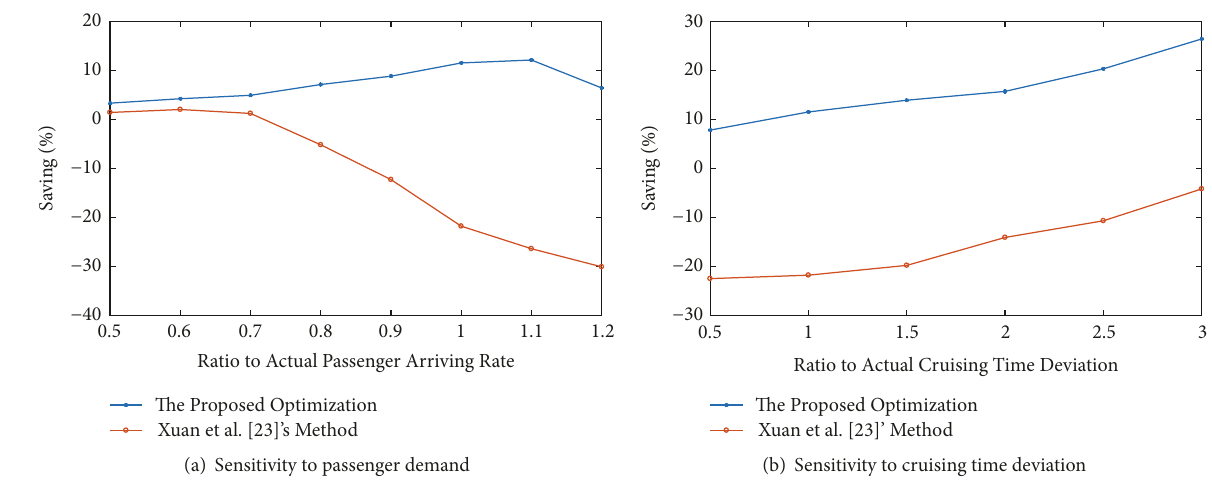
Figure 7: Saving of passenger travel time under different passenger demand and cruising time